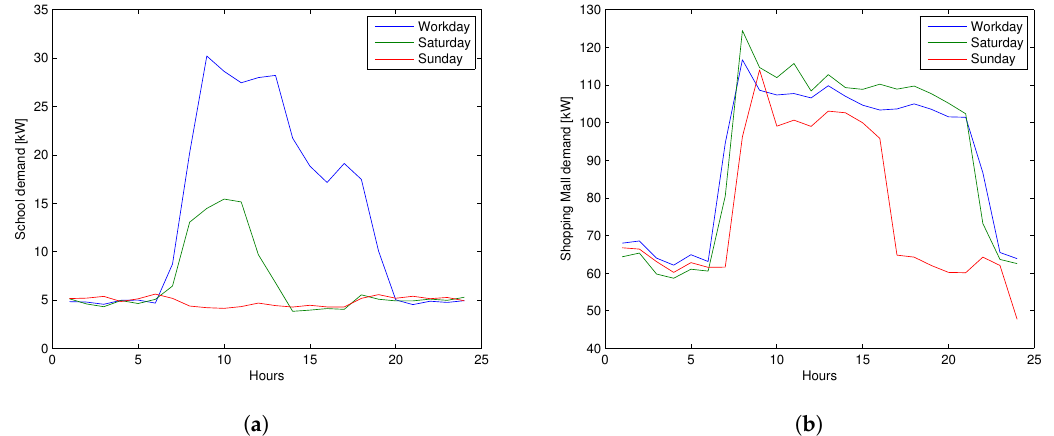
Figure 6. Elementary School and Shopping Mall curves for three representative days of week: (i) Workday, (ii) Saturday and (iii) Sunday. ( a ) Elementary School; ( b ) Shopping